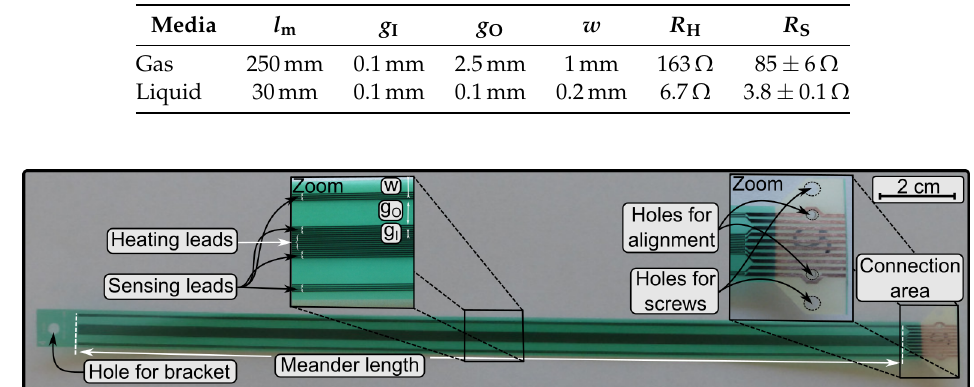
Table 1. Geometrical and electrical parameters of the sensor: l m is the meander length of the leads, g I denote the gap between the heater and the inner sensing leads, g O the gap between the inner and outer sensing leads, and w specifies the distance (wing width) between the outmost leads and the PCB edges. R H denote the heater resistance and R S the mean resistance with standard deviation of the sensor.